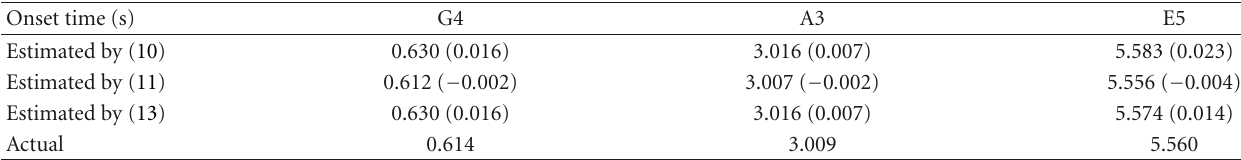
Table 1: Onset detection results by the proprosed approach as compared with the true values marked manually. The deviations between the estimated and the actual onset time are denoted in